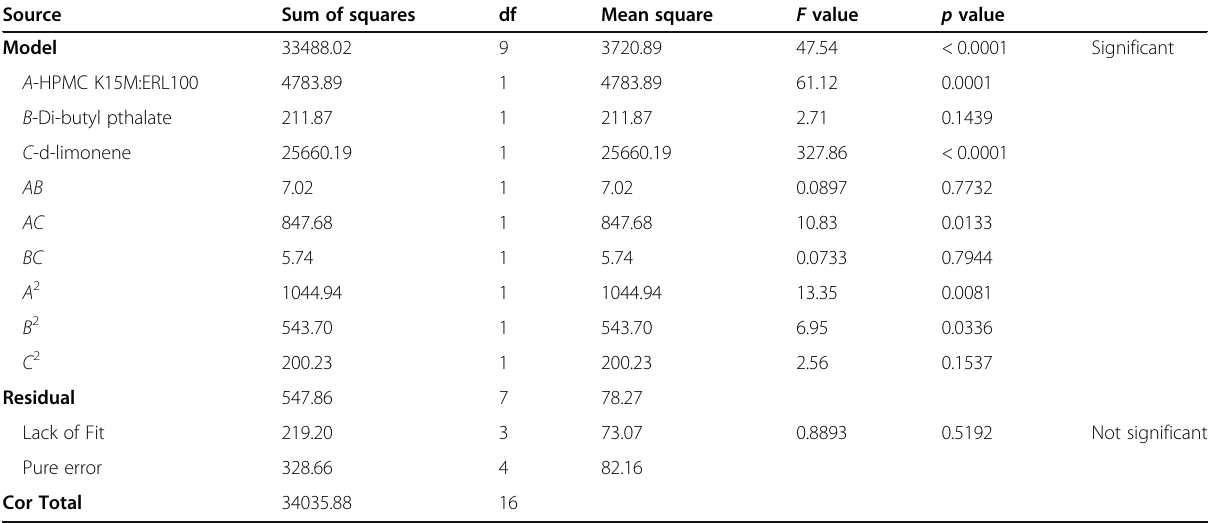
Table 5 ANOVA for the quadratic model (steady-state flux response)